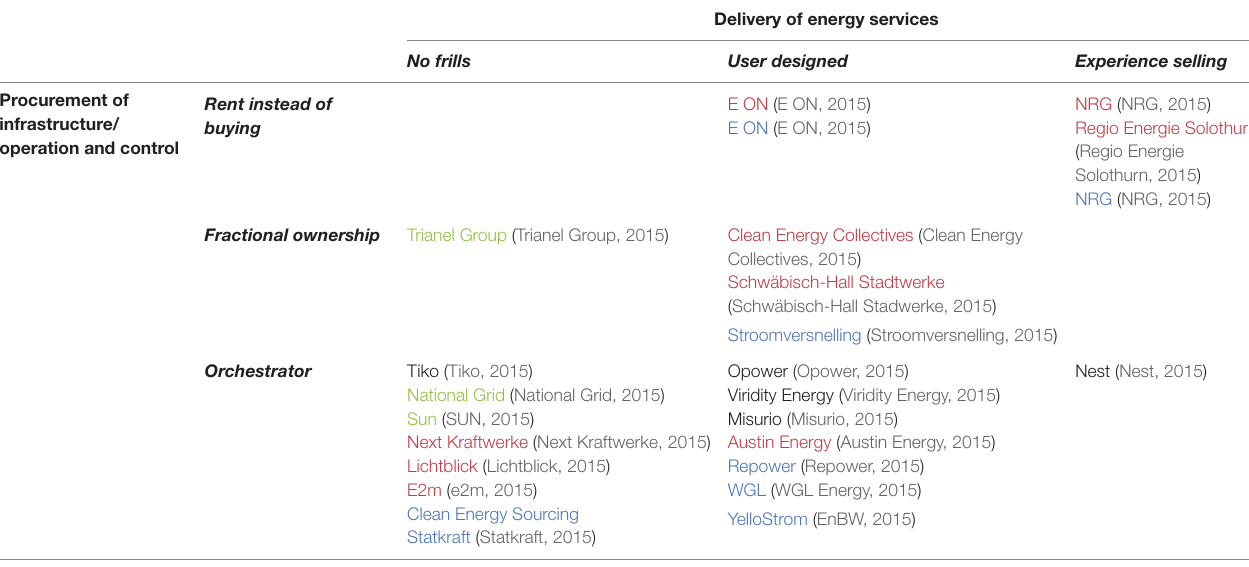
TaBle 5 | allocation of emerging business models within the business model solution